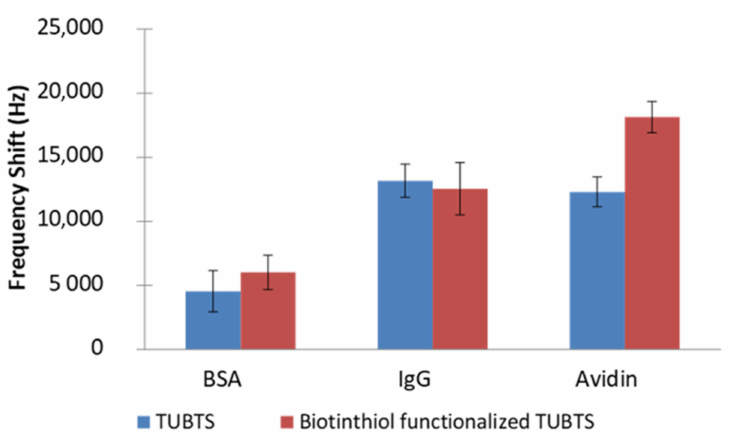
Figure 5. EMPAS frequency shifts measured with TUBTS and biotinylated TUBTS self-assembling monolayers (SAMs), using 0.1 mg mL − 1 BSA, IgG, and avidin solutions in PBS buffer